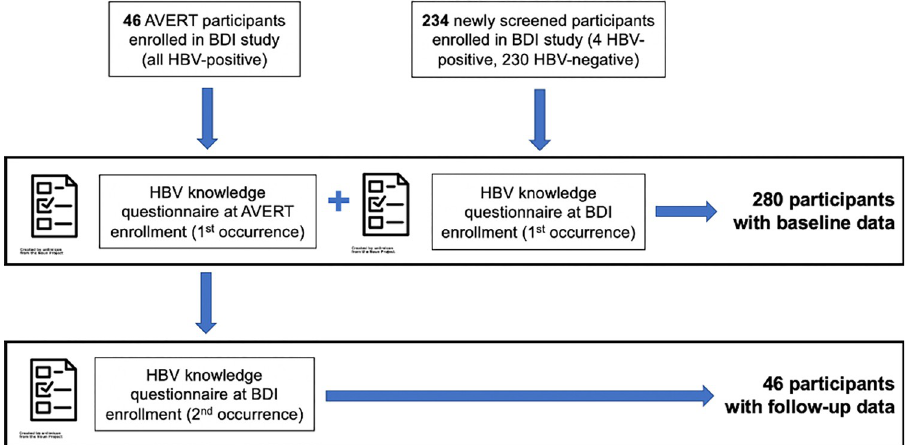
Fig 1. Schematic depicting activities in the AVERT and BDI studies, including the point at which enrollment questionnaires were